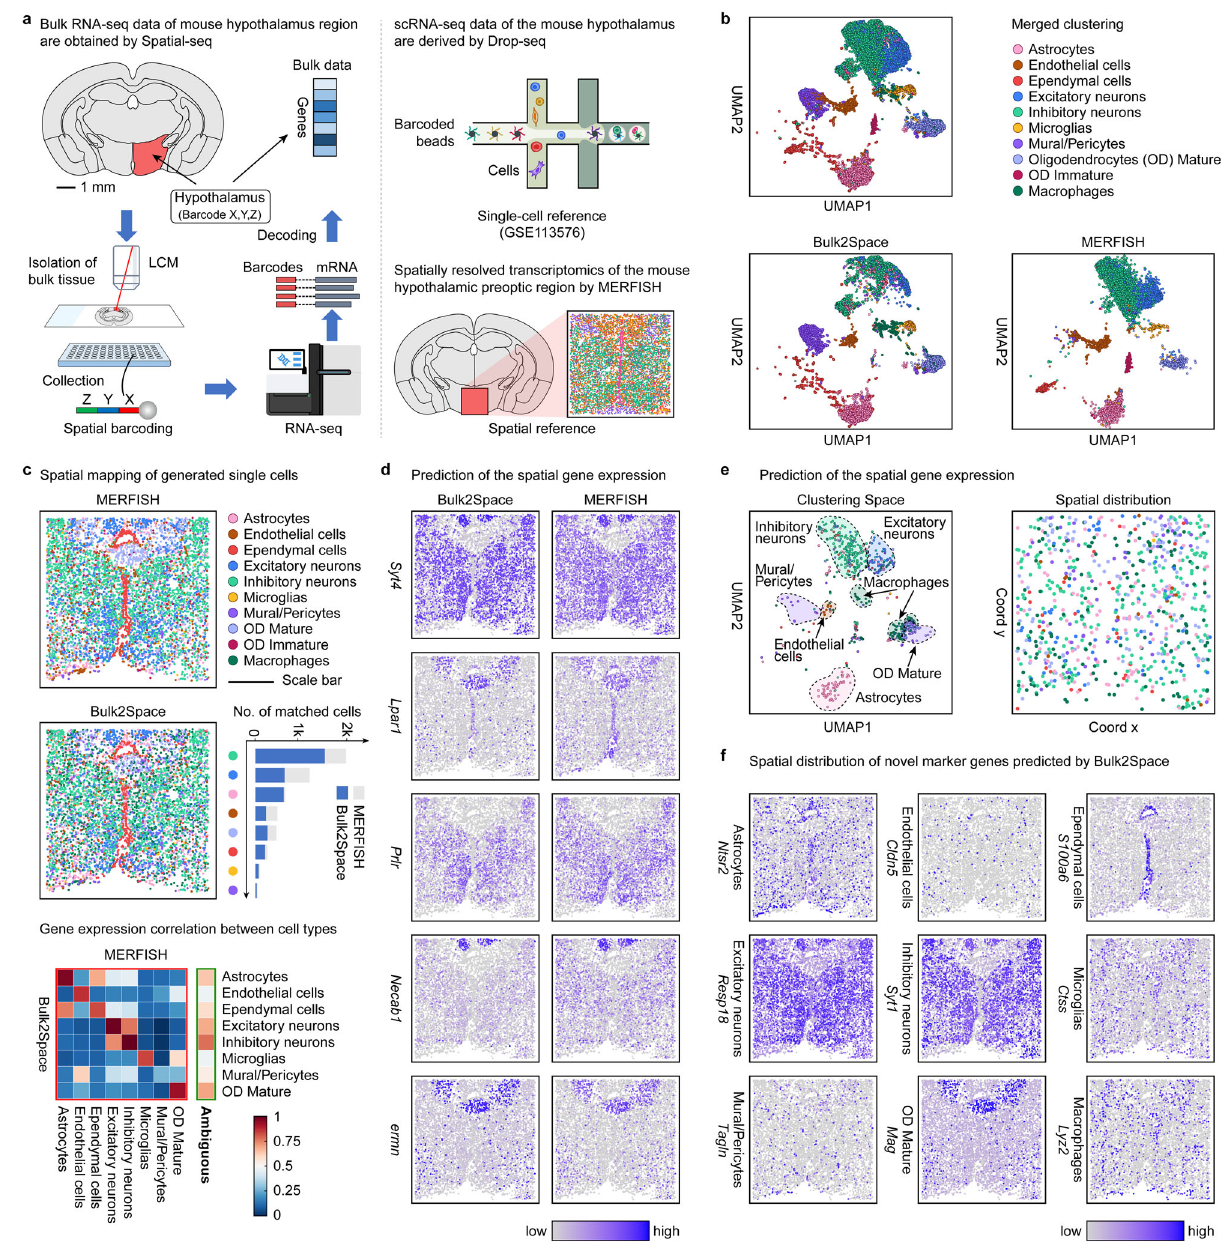
Fig. 5 | Spatially resolved analysis of the mouse hypothalamus bulk data by Bulk2Space. a The resources of the bulktranscriptome data, single-cell reference, and spatial reference. The bulk RNA-seq data of the mouse hypothalamus was pro fi led using our in-house developed Spatial-seq. The single-cell reference data was derived from Drop-seq. The spatial reference data is obtained from MERFISH. b TheUMAPlayoutofsingle-cellpro fi lesinMERFISHdataandgeneratedfrombulk tissue by Bulk2Space. Top, clustering of all cells in both datasets. Two hetero- geneous sets of data were aligned through a joint analysis. Each cell type was represented by a unique color. c The spatial distribution of distinct cells in MER- FISHandBulk2Spaceresults.Thestackedbarchartshowedthecellnumberofeach cell type (gray) and the number of cells predicted by Bulk2Space to the